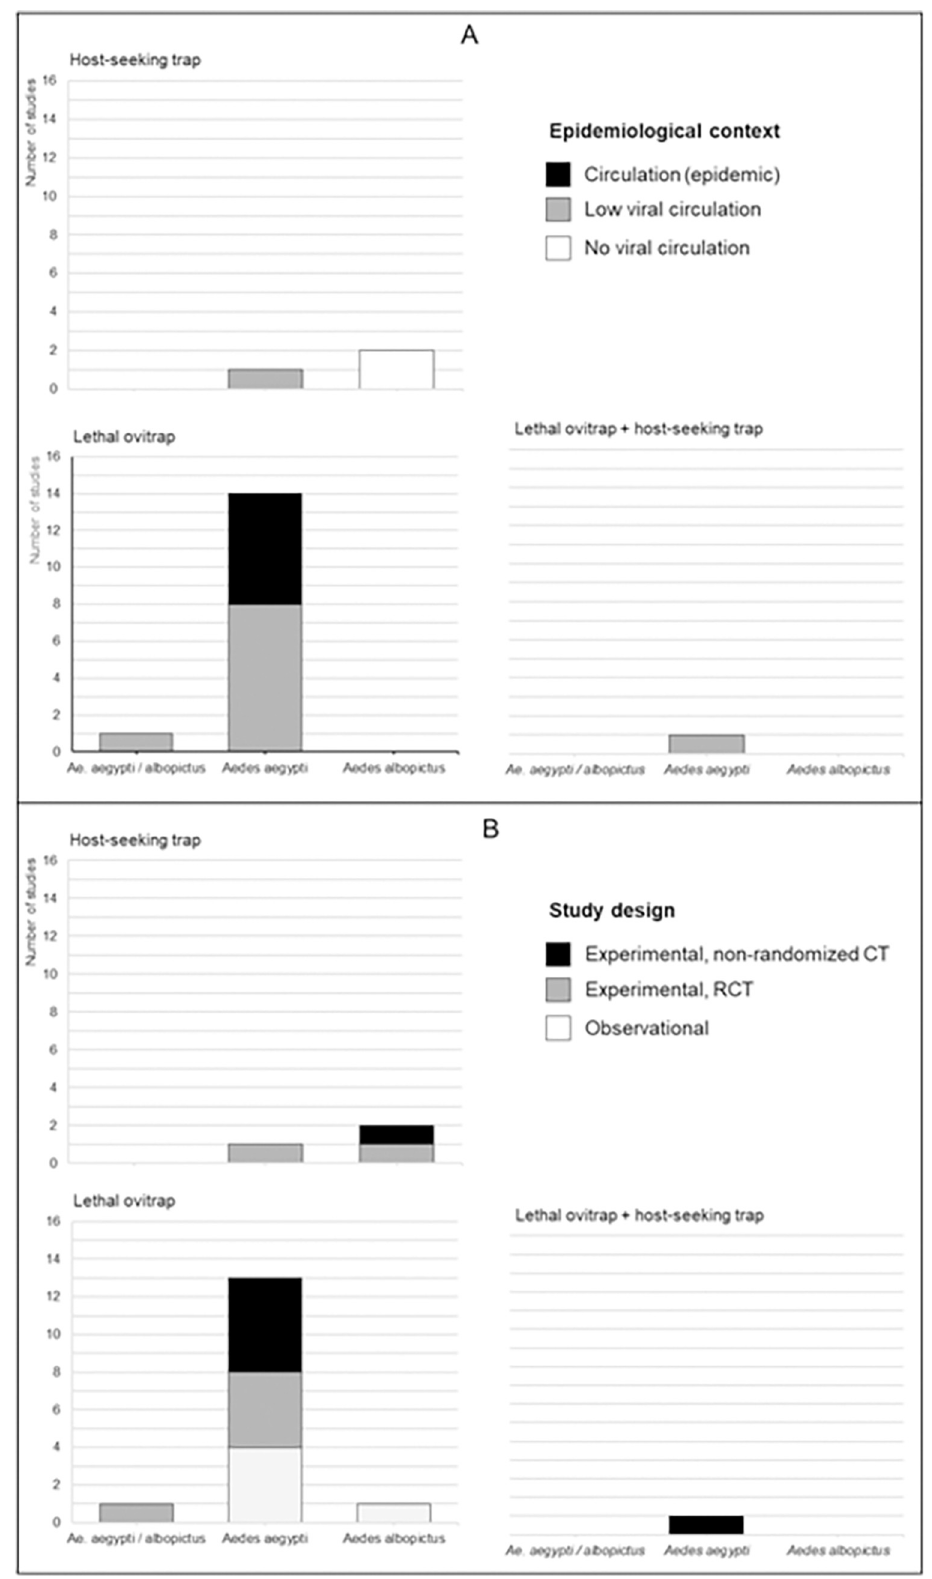
Fig 2. Distribution of selected articles according to the target species, the traps used and (A) the epidemiological context of the study (B) the study design. Lethal ovitrap includes AGO, GAT and Sticky traps. https://doi.org/10.1371/journal.pntd.0011153.g002 PLOS NeglectedTropical Diseases | https://doi.org/10.1371/journal.pntd.0011153 March 6,